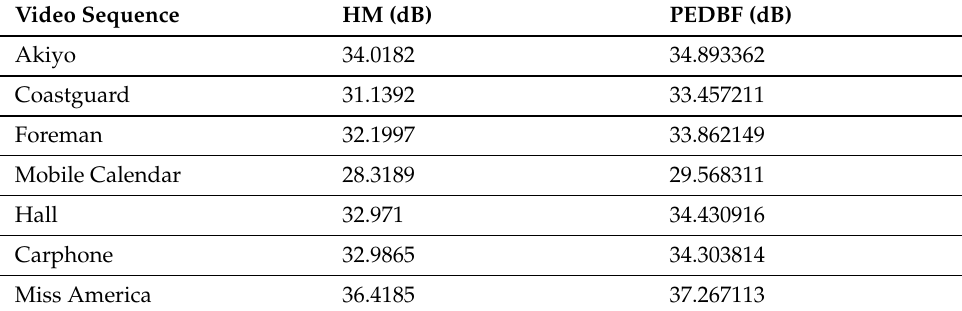
Table 5. PSNR of QCIF video sequences with QP = 37.